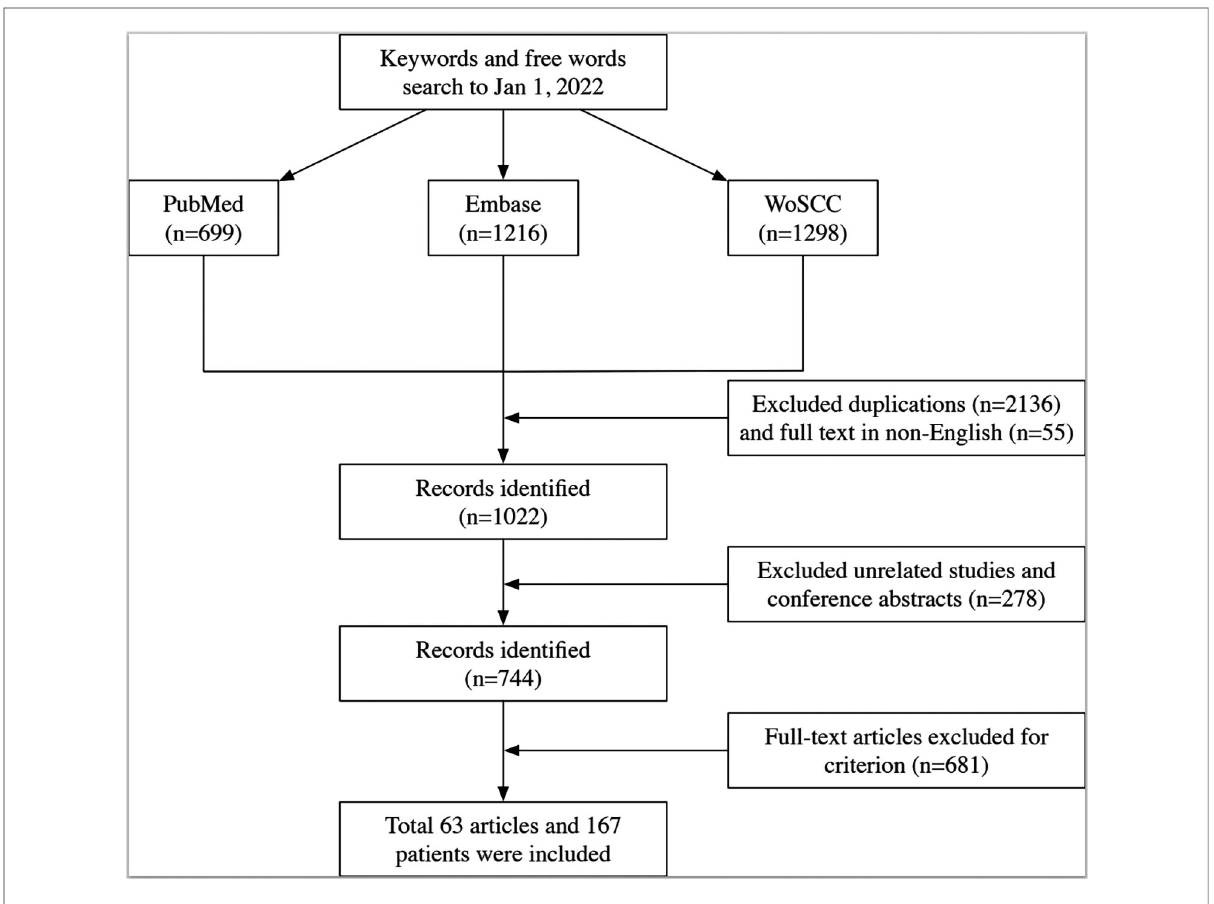
FIGURE 1 Flow chart of included